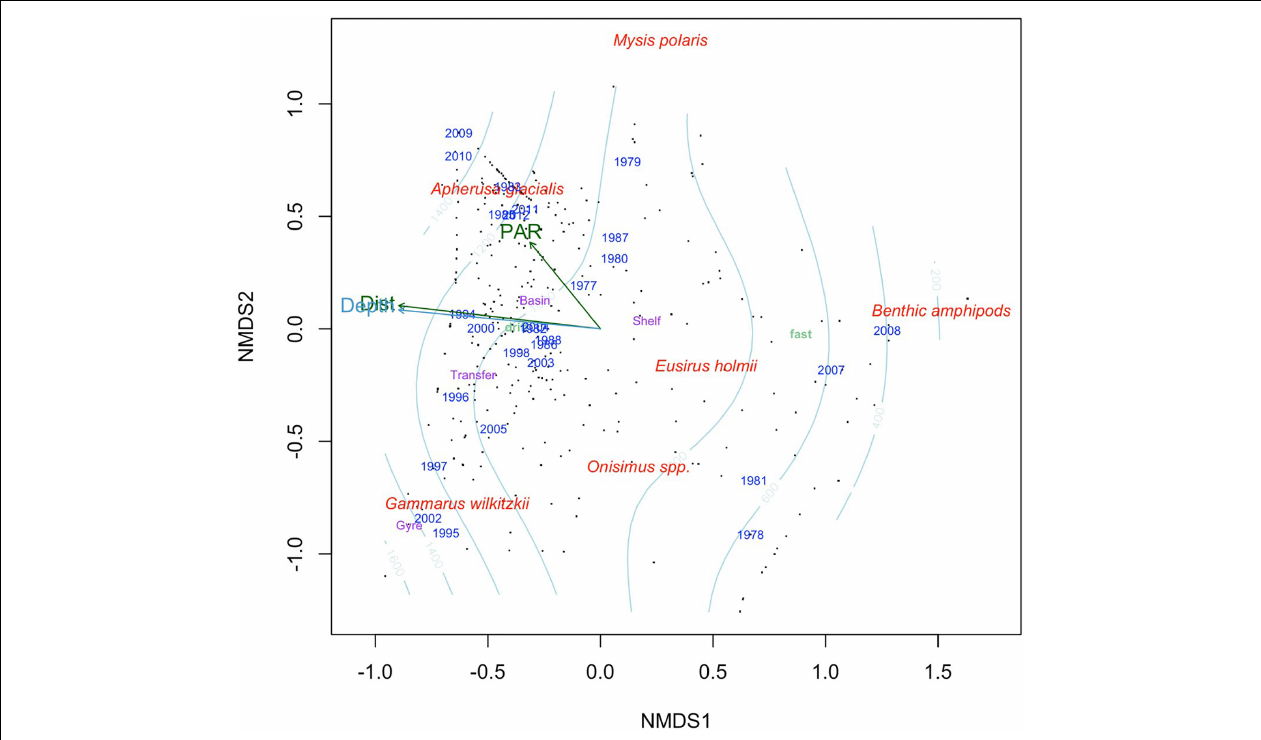
FIGURE 7 | Non-metric multidimensional scaling using Bray-Curtis dissimilarity matrix calculated from the percentage data. Black dots indicate samples, red text is species scores fitted using square-root transformation and Wisconsin double standardization, the light blue contour indicates bottom depth, light green text is ice type (landfast ice and drift ice) and purple text indicates region. The arrows represent continuous variables fitted to the ordination, while text indicates categorical variables. Dist, distance from land; PAR, photosynthetic active radiation.